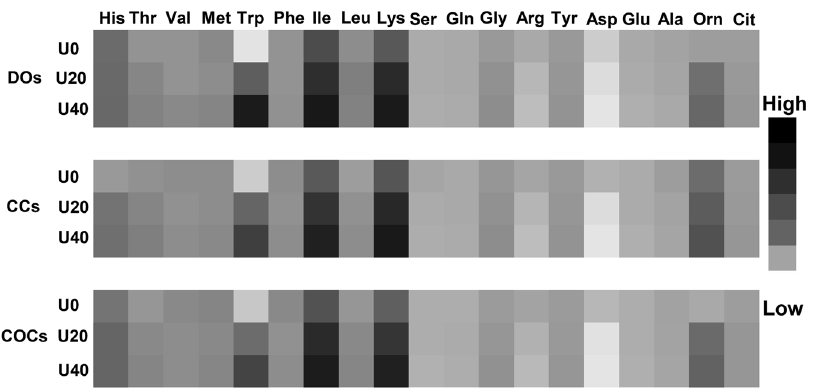
Figure 6. Marginal effects analysis to evaluate the sensitivity of amino acid depletion to the different levels of urea. Marginal effects analysis can detect how smaller changes in urea concentration (one-tenth intervals from 0 to 40 mg/dl) affect instantaneous changes in amino acid turnover. Marginal effects analysis determined that the turnover of isoleucine, lysine, and tryptophan were more sensitive to urea and estimated that the sensitivity of these amino acids to urea was greater in DOs (darker squares). U0: control (without urea); U20: 20 mg/dl urea; U40: 40 mg/dl urea. COCs: cumulus-oocyte complex; CCs: cumulus cells; DOs: denuded oocytes. “High” and “low” mean “greater” and “lower” turnover to urea,